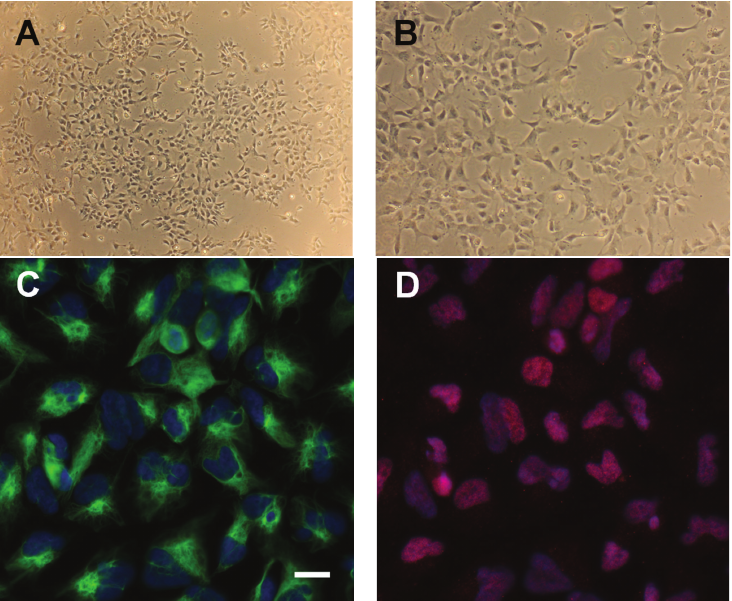
Figure 5: Characterization of NPCs. (A) and (B) NPC morphology was observed under phase-contrast microscopy with 5x (A and 10x (B) magnification. (C and D) NPCs expressed Nestin (green) (C) and Sox1 (red). (D) Nuclei were counterstained with DAPI (blue). Scale bar represents 20 μ